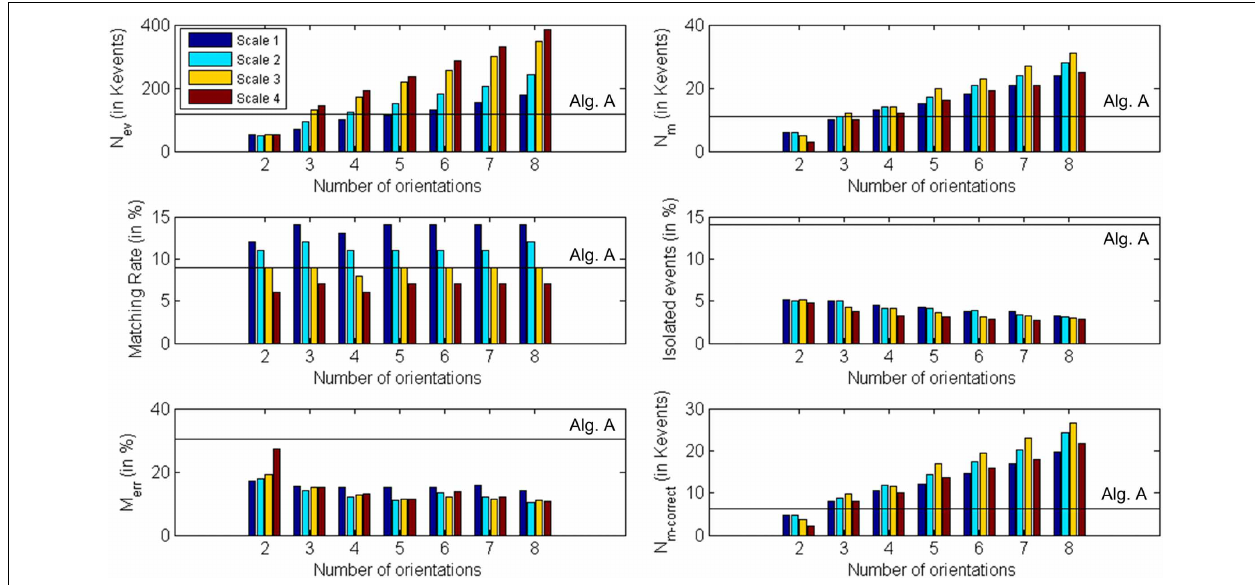
FIGURE 20 | Graphical representation of Table 3. Each subplot corresponds to a different row of the table, showing the obtained values for each number of orientations and scale. The black horizontal lines indicate the values obtained using algorithm A (0